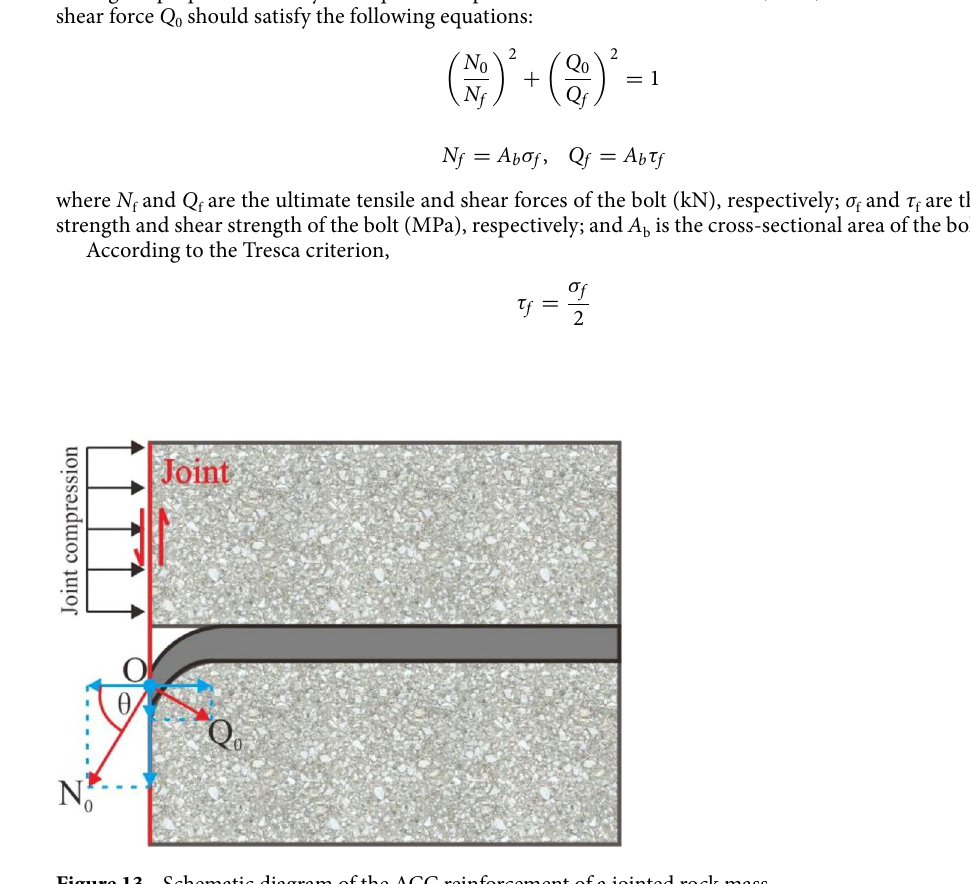
Figure 13. Schematic diagram of the ACC reinforcement of a jointed rock